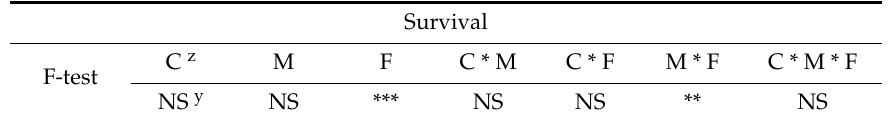
Table 1. The e ff ects of the medium, fogging duration and cultivar on the survival of strawberry daughter plants after 15 days treatment.